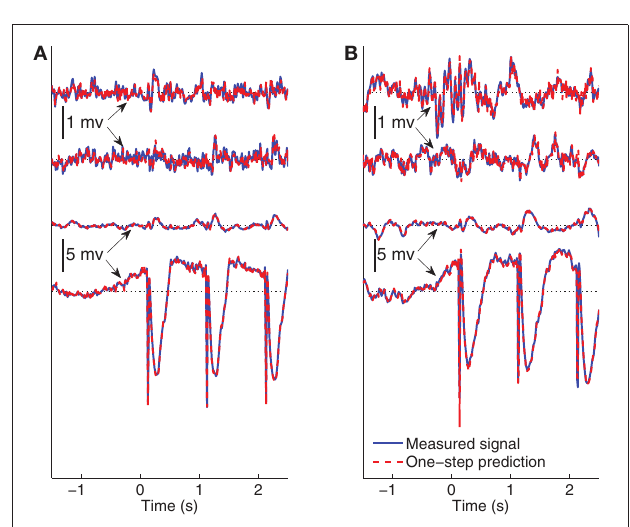
FIGURE 10 | Exogenous input filters B for each channel as a function of time. The identical colormap is used for each row. (A) Subject A wake, 1mA. (B) Subject A sleep, 1mA. (C) Subject A wake, 5mA. (D) Subject A sleep, 5mA. (E) Subject B wake, stimulation site L1. (F) Subject B sleep, stimulation site L1. (G) Subject B wake, stimulation site L2. (H) Subject B sleep, stimulation site L2. (I) Subject C wake. (J) Subject C